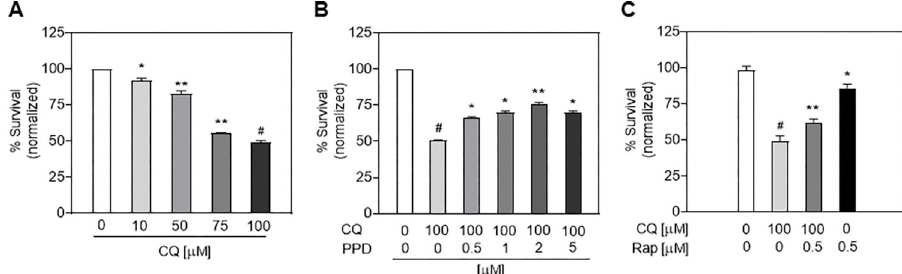
Fig 1. Protective effect of protopanaxadiol (PPD) on chloroquine (CQ)-induced adult retinal pigment epithelial (ARPE)-19 cell death and possible autophagy involvement. Cytotoxicity of (A) various CQ concentrations (0, 10, 50, 75, 100 μ M), (B) co-treatment with 100 μ M CQ and vehicle or different PPD concentrations (0.5, 1, 2, 5 μ M), or (C) 0.5 μ M rapamycin (Rap) for 24 h in ARPE-19 cells. Cytotoxicity was assessed using 3-(4,5-dimethyl-thiazol-2-yl)- 2,5-diphenyltetrazolium bromide (MTT) assay. Mean ± standard deviation (SD), n = 3; � P < 0.05, �� P < 0.01, and # P < 0.001 compared to vehicle